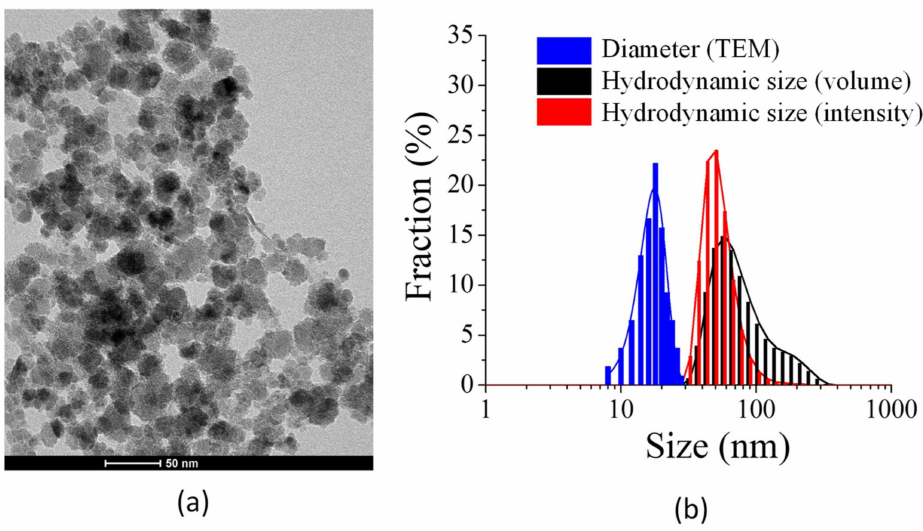
Figure 2. ( a ) Transmission electron microscopy (TEM) images of nanoparticles functionalized with folic acid. ( b ) Comparison of the nanoparticle size and hydrodynamic size